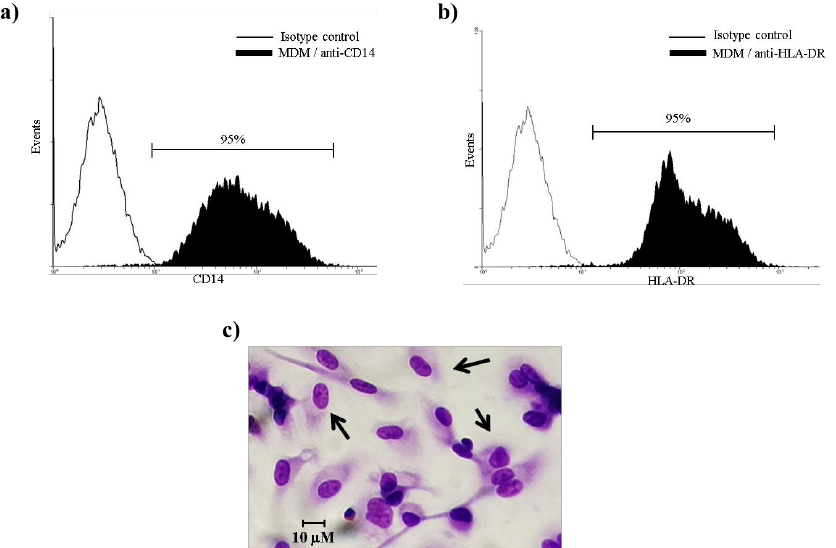
Figure 1. Purity and morphological identification of monocyte-derived macrophages (MDMs). CD14